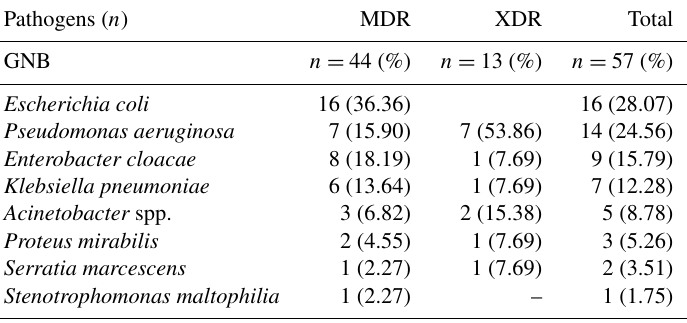
Table 1. Identification of Gram-negative bacteria (GNB) multidrug-resistant (MDR) and extensively drug-resistant (XDR) bacteria in osteosynthesis-associated infection of the lower limbs.